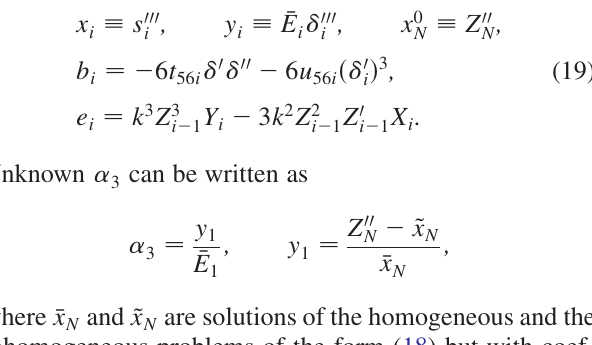
FIG. 5. The left plot presents the rf parameters of module M right-hand side presents the change of the relative compression j (cid:1) C